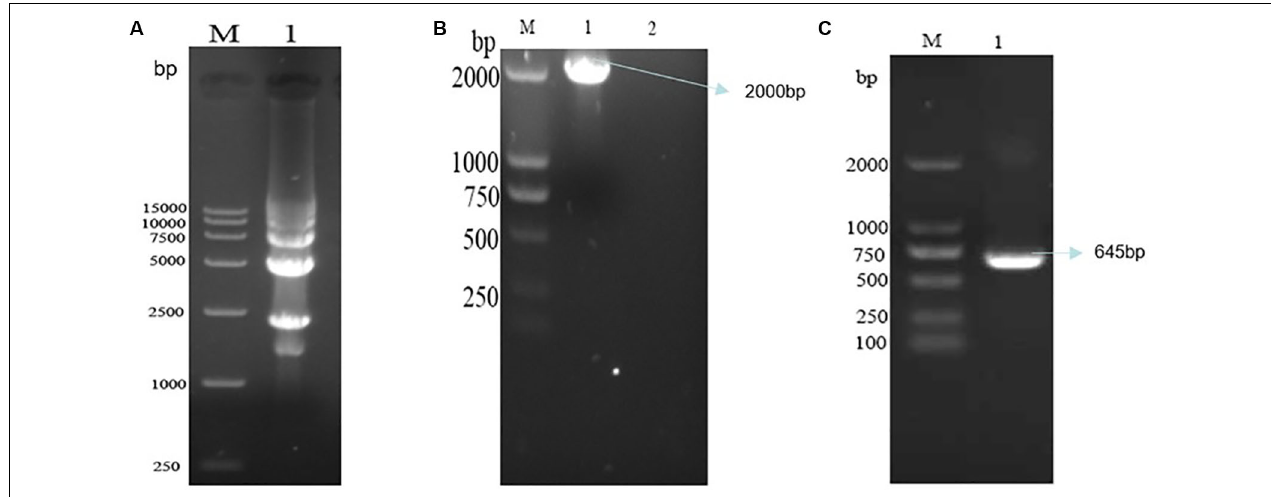
FIGURE 2 | The detection of cyclized PCV3 DNA and the screening of recombinant plasmids. (A) Electrophoresis results of PCV3 DNA nucleic acid after cyclization. M, DL15000 DNA Marker; Lane 1, cyclized PCV3 DNA. (B) Nucleic acid electrophoresis results of cyclized PCV3 DNA common PCR products, and the size of the amplified PCR products were 2000 bp. M, DL2000 DNA Marker; Lane 1, PCR products of the supernatant of transfected cells; Lane 2, PCR products of the supernatant of normal cells. (C) Nucleic acid electrophoresis results of cyclized PCV3 DNA RT-PCR products, and the size of the amplified PCR products were 645 bp. M, DL2000 DNA Marker; Lane 1, RT-PCR products of the supernatant of transfected